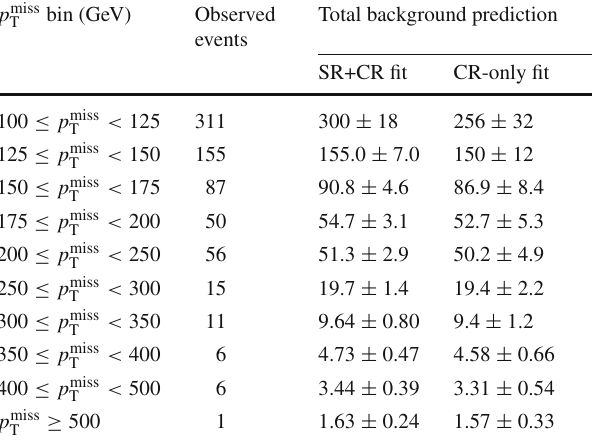
Table 4 Expected event yields in each p miss ground processes in the SR. The background yields and their corre- sponding uncertainties are obtained after performing a fit to data. Two sets of background yields are reported: one from a background-only fit to data in both the SR and the CRs, and one from a fit to data in all CRs, but excluding data in the SR. The observed numbers of events in each